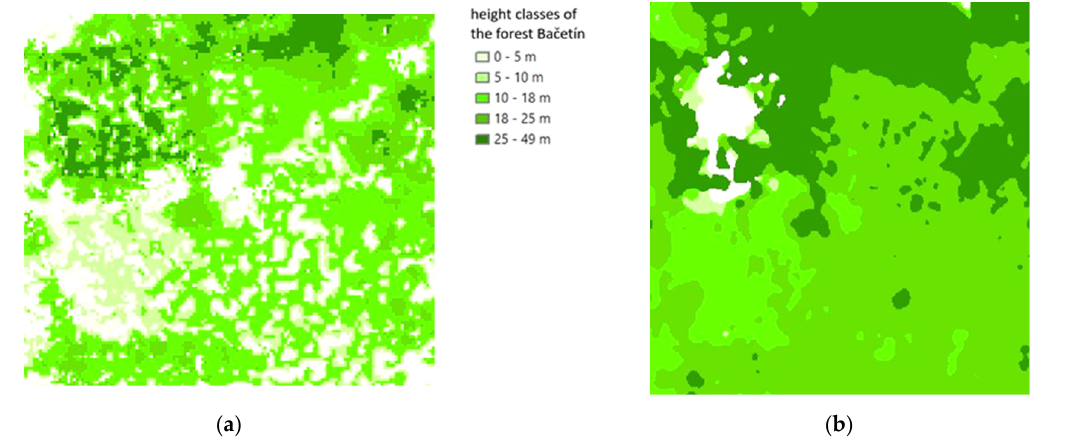
Figure 4. ( a ). The comparison of different raster of heights of the selected Forest Ba č etín. A raster created from DSM 1G shows more detailed structure of the forest represented for example by blank spots across the picture. ( b ) A raster based on DSM created from orthophoto is smoother; however, because of generalization of surface, it does not include detailed missing values of heights in data. Same region displayed in both pictures; it has size of 200 × 200 m.